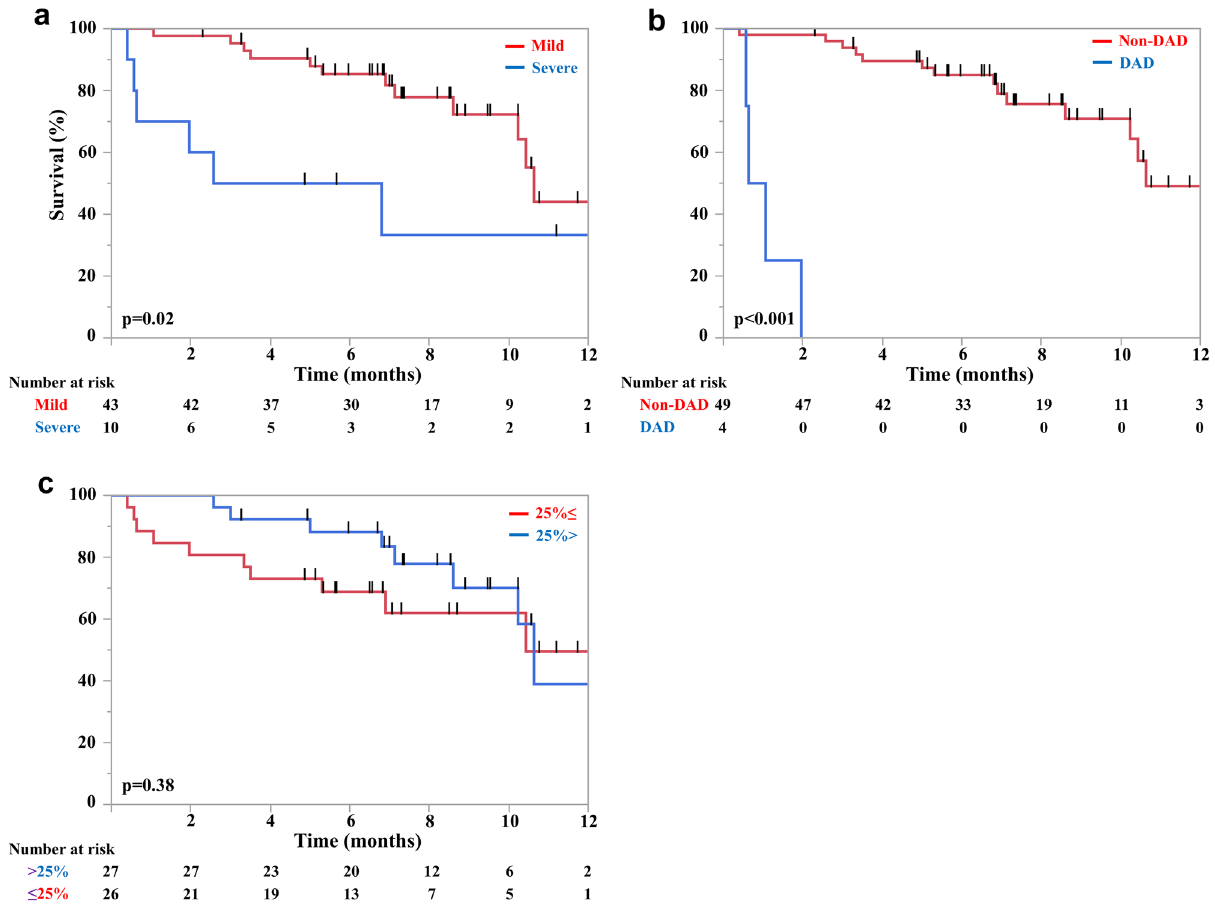
Figure 1. Kaplan–Meier survival curves of overall survival stratified by the severity of pneumonitis (mild or severe) ( a ) computed tomography image patterns (diffuse alveolar damage [DAD] or non-DAD) and ( b ) extent of pneumonitis at diagnosis (extent < 25% or ≥ 25%) ( c